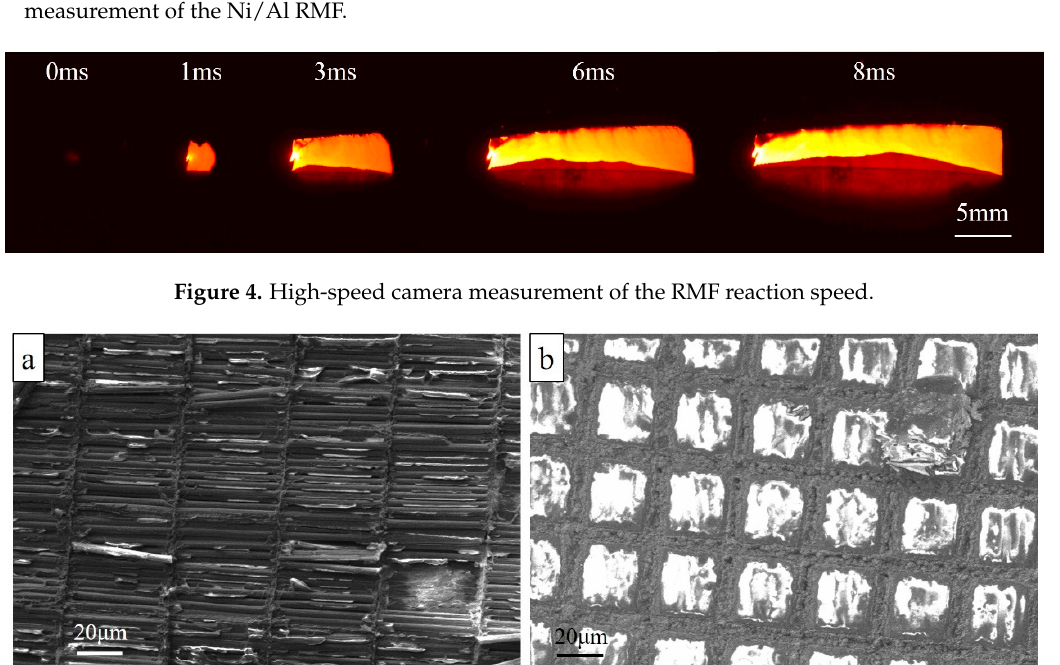
Figure 3. ( a ) XRD pattern of the as-deposited Ni/Al RMF; ( b ) differential scanning calorimetry (DSC) measurement of the Ni/Al RMF.